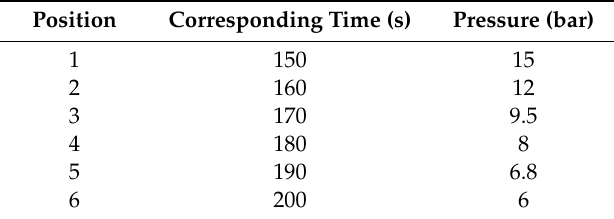
Table 3. Corresponding times and pressure in the simulation.